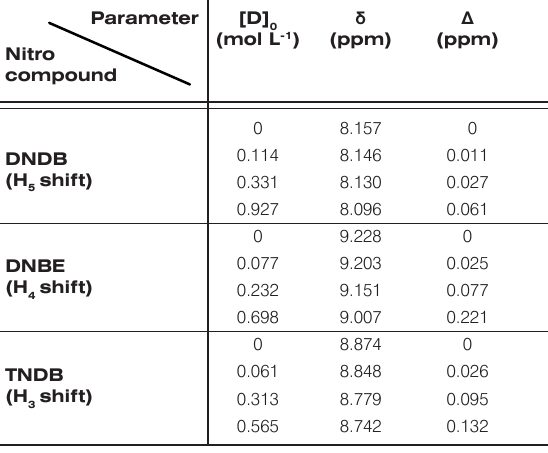
Table 2. Chemical shifts of DNDB, DNBE, and TNDB complexed with PVK for different molar ratios in mixtures.